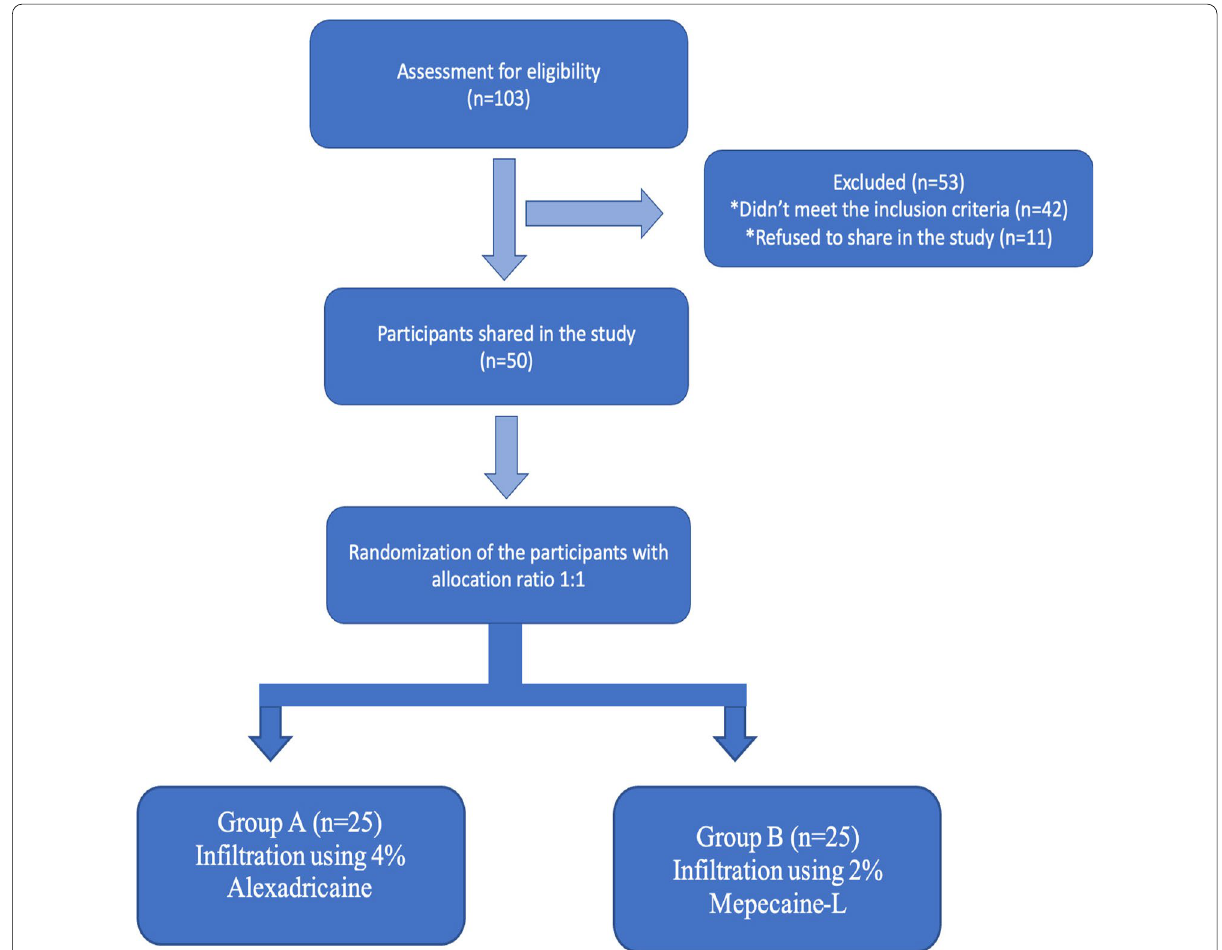
Fig. 1 Flow chart of the patients enrolled in the study. Group A: Infiltration injection was performed using 4% Alexadricaine*. Group B: Infiltration injection was performed using 2% Mepecaine-L**. (4% Alexadricaine and 2% Mepecaine-L manufactured by Alexandria co. for pharmaceuticals—